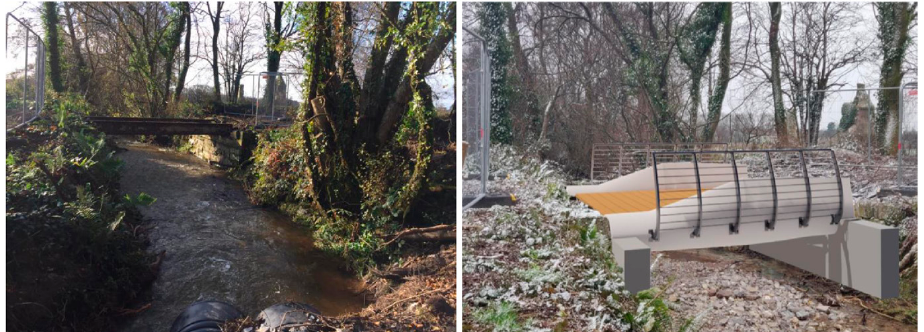
Figure A2. An existing structure on a greenway route at Roxborough, Midleton, Cork. A conceptual design of a blade bridge at the same location [44].